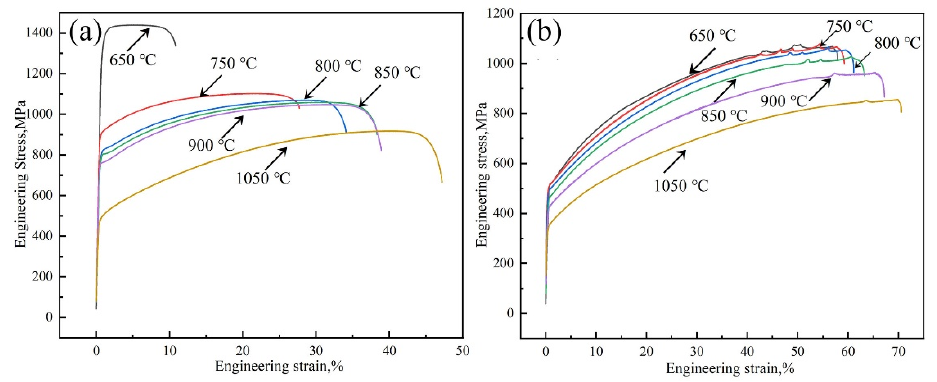
Figure 6. Engineering stress–strain curves of steels after solid solution treatment at different tem- peratures for 6 min: ( a ) steel 1# and ( b ) steel 2#. atures for 6 min: ( a ) steel 1# and ( b ) steel 2#.